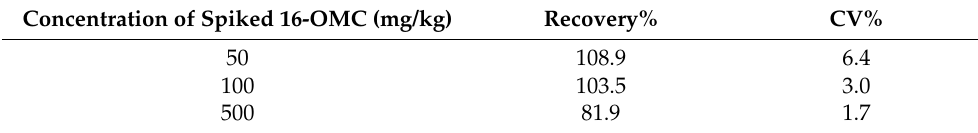
Table 2. Recovery and precision of blank coffee spiked with 16-OMC standard. Concentration of Spiked 16-OMC (mg/kg)